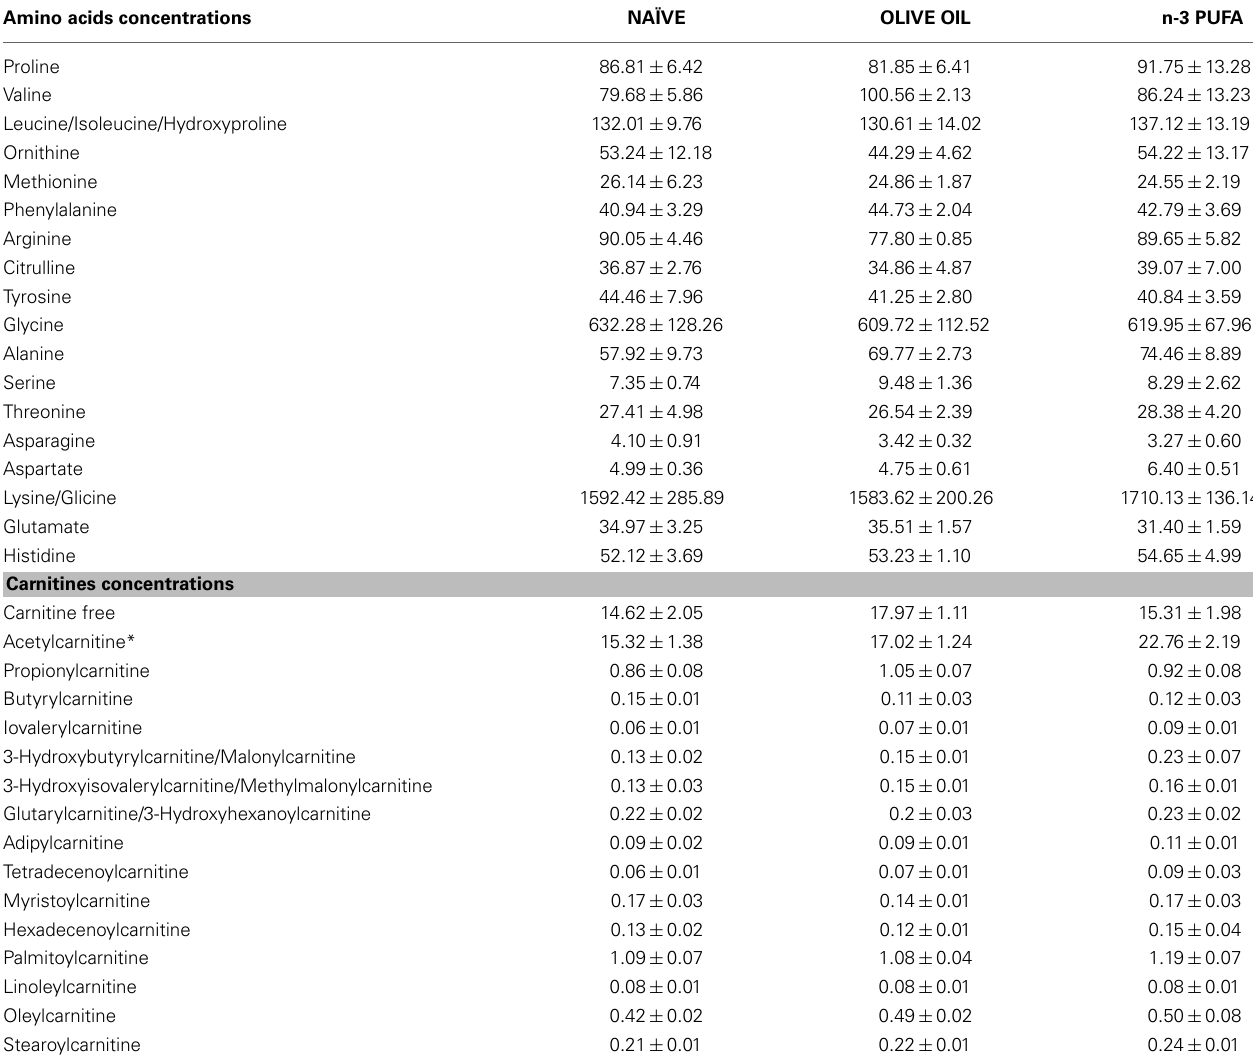
Table 2 | Blood concentrations of amino acids and carnitines for each experimental group are indicated. Amino acids